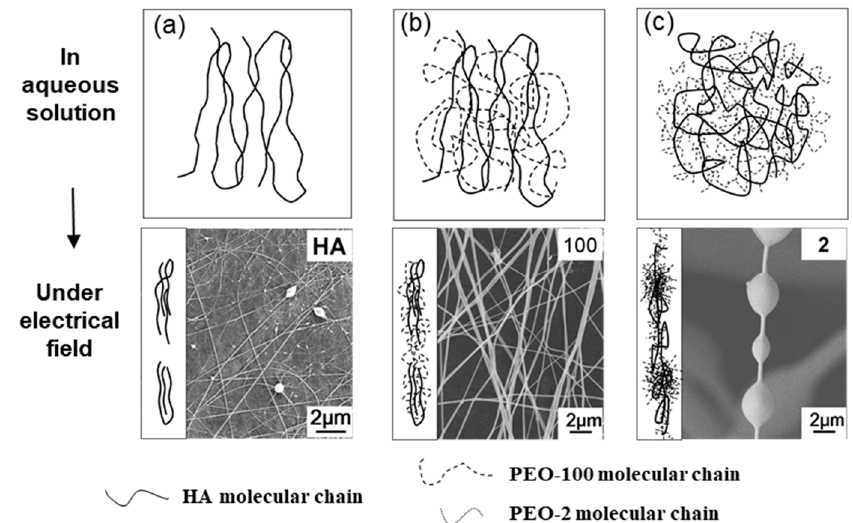
Figure 5. The chain entanglement model: ( a ) Pure HA, stiff polymer chains, only form few flections, and polymer chains will slip away when elongated by electric field; ( b ) HA/PEO-100 blends. Flexible PEO-100 chains pass through HA and entangle with other PEO molecules, and stabilize electric spinning process; ( c ) HA/PEO-2 blends. PEO-2, much smaller molecules, reduce the electrostatic repulsive forces and hydrogen bonding interaction, to make HA chains more flexible and form efficient entanglements.